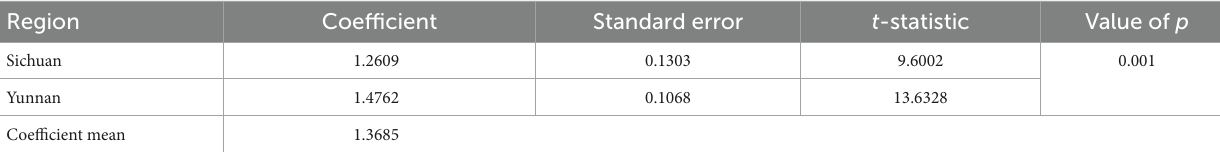
TABLE 10 Results of the regression coefficients for Class III regions. Region